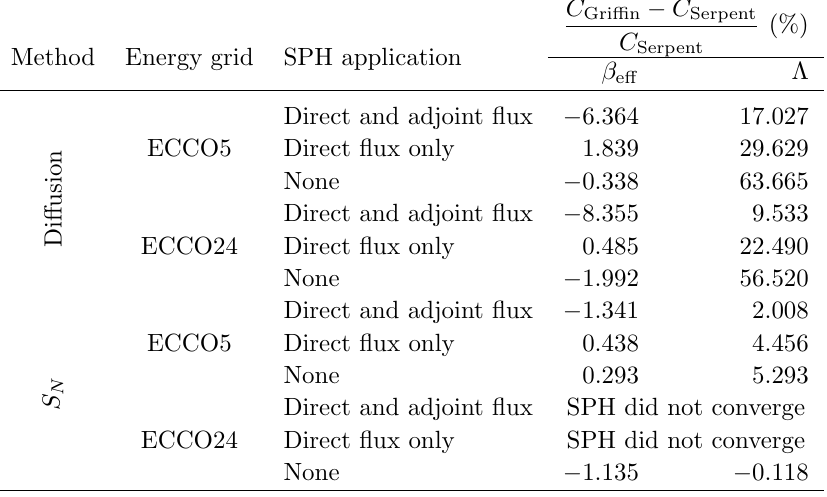
Table 21. Relative differences between Griffin and Serpent Flattop-23 kinetics parameters.